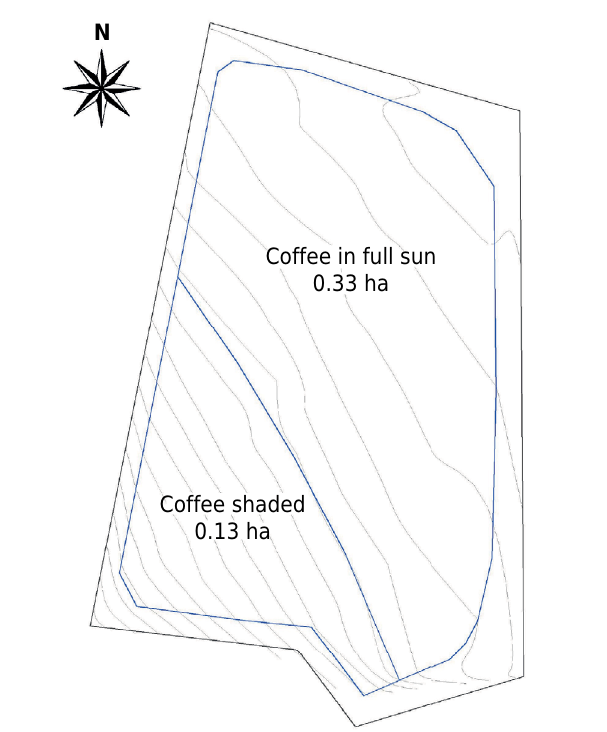
Figure 1. Planialtimetric survey of the experimental